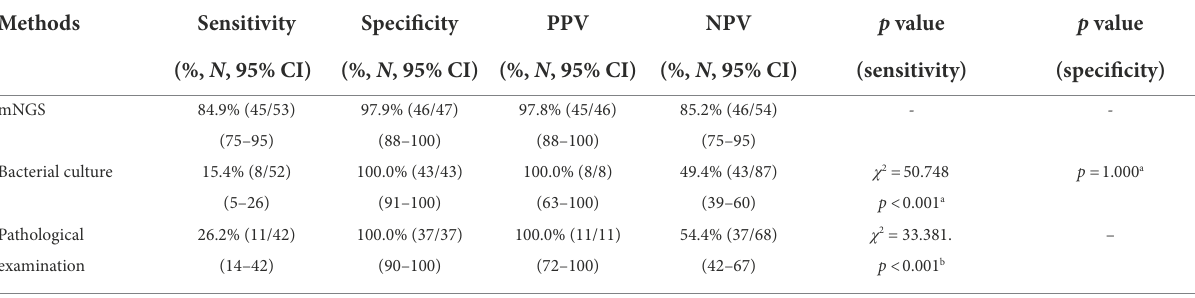
TABLE 4 Performance of mNGS and conventional detection methods in patients with non-TB spinal